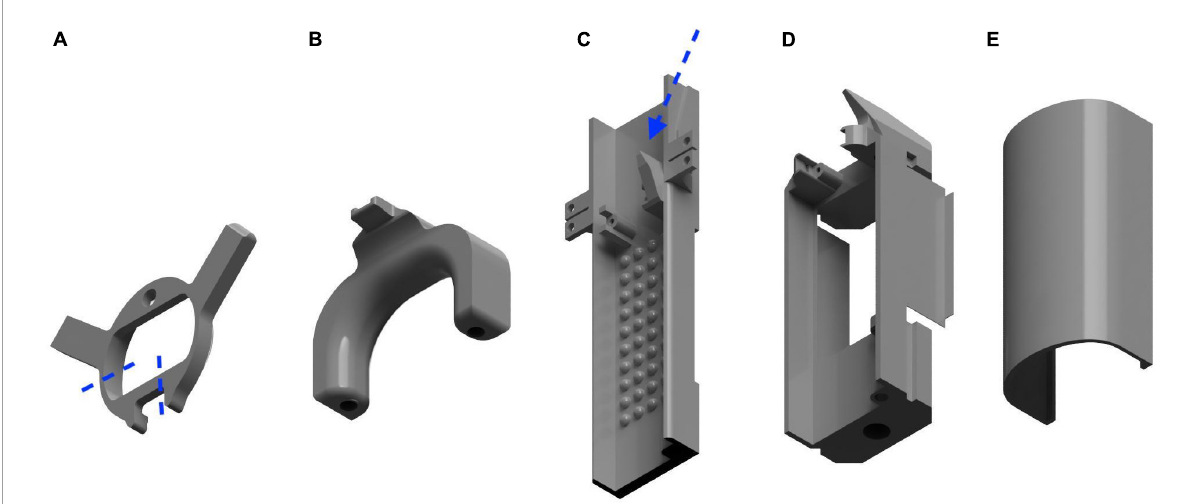
FIGURE1 3D designs for awake-restrained imaging. (A) Frontal head holder with markers (blue) for cutting to allow space for the collar; (B) Collar head holder for neck stabilization. Holes in the base are threaded prior to surgery for fixation to the bed using plastic screws; (C) MRI imaging bed with air-puff applicator (blue arrow); (D) Optical imaging bed; (E) Lid for optical imaging